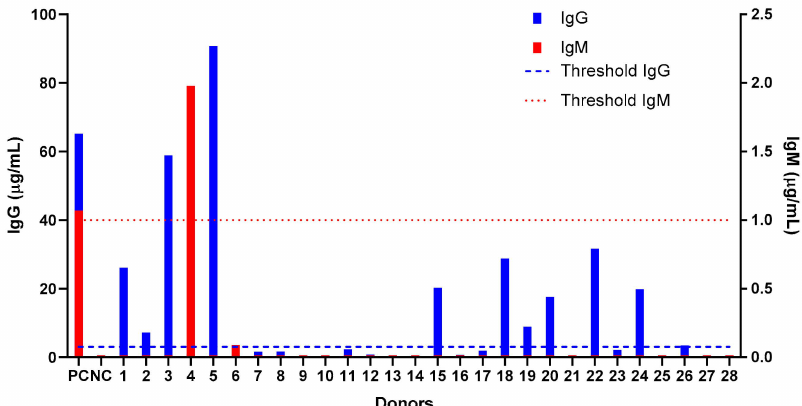
Figure 6. Screening of healthy donors for pre-existing antibodies against polyethylene glycol (anti-PEG IgG and IgM). Blood was collected from healthy donors ( n = 28, 14 men and 14 women) and the sera were assessed for the presence of natural anti-PEG antibodies using a direct ELISA against immobilized PEG. The positive threshold was defined as 3 times the value of background for each antibody. Each positive result was confirmed by competition assay against PEGylated liposomes. Dashed line indicates the positive threshold for IgG and dotted line the positive threshold for IgM